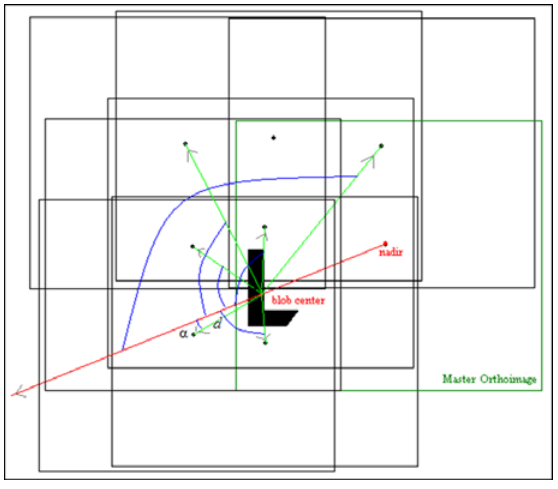
Figure 5. Segment oriented compensation (frame